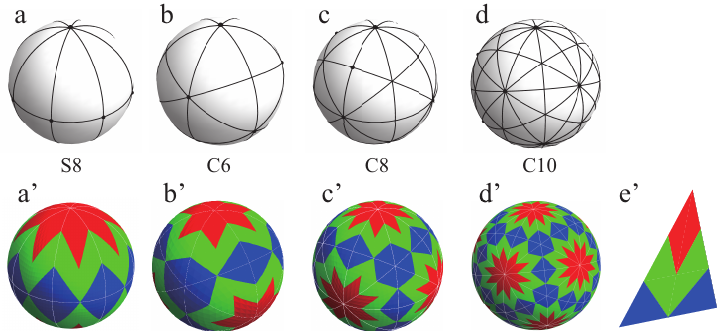
Fig. 1 a-d:Traditional basic divisions (S8, C6, C8, and C10, from left to right). Large Figure 3. ( a – d ):Traditional basic divisions (S8, C6, C8, and C10, from left to right). Large marks on the marks on the top denote poles. a’-d’: Spherical patterns corresponding to a-d. e’: A top denote poles. ( a’ – d’ ): Spherical patterns corresponding to ( a – d ). ( e’ ): A simple textured triangular simple textured triangular unit used to construct spherical patterns a’-d’. unit used to construct spherical patterns ( a’ – d’